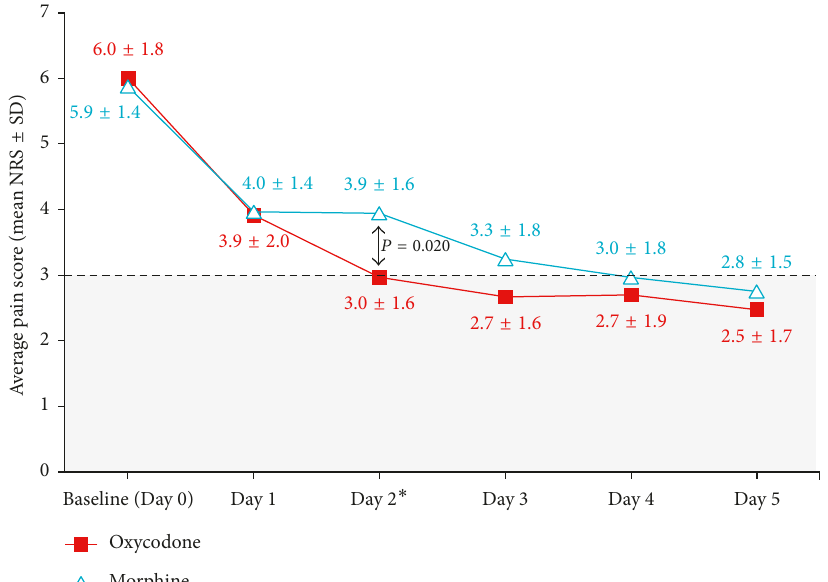
Figure 3: Average NRS pain scores. Difference between average pain scores is significant. NRS (cid:30) Numerical Rating Scale (0–10 points, 0 (cid:30) no pain and 10 (cid:30) worst pain). ∗ Table 2: Change in average, worst, and current NRS